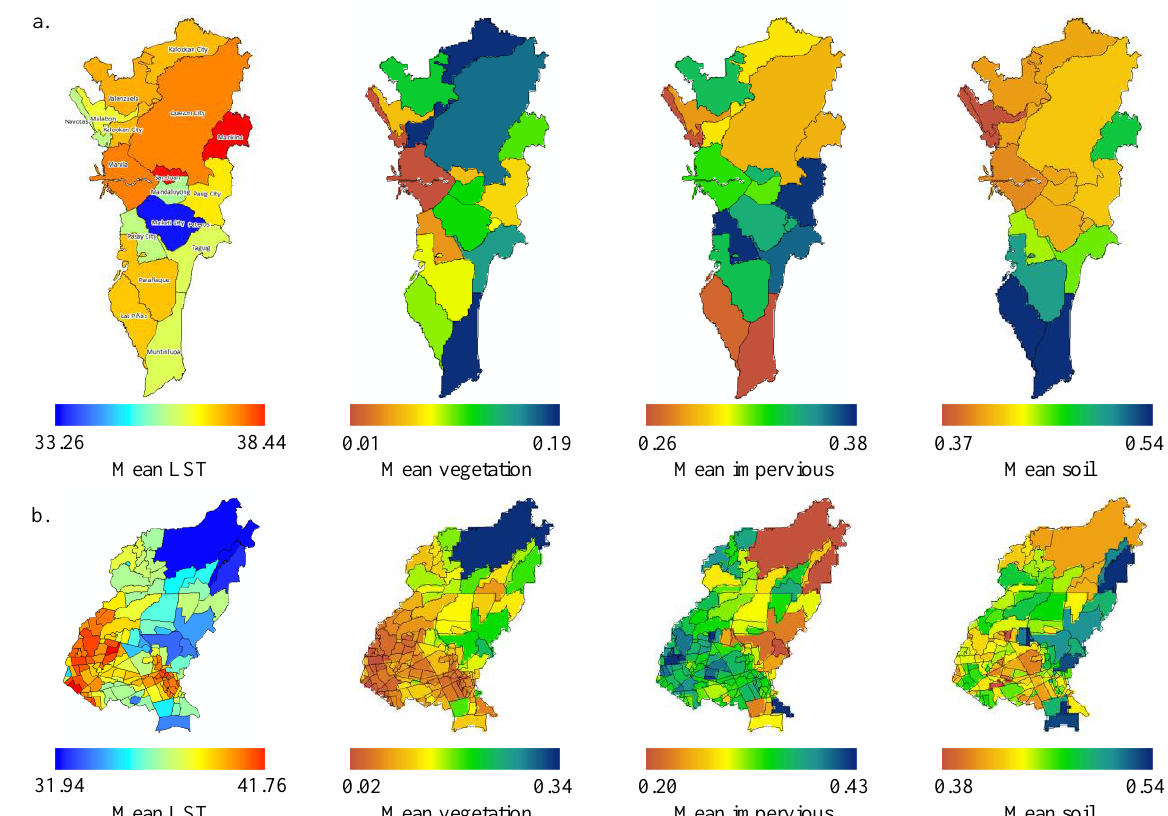
Figure 11. Mean land surface temperature, vegetation, impervious surface, and soil for each city in Metro Manila (a) and for each barangay in Quezon City (b)